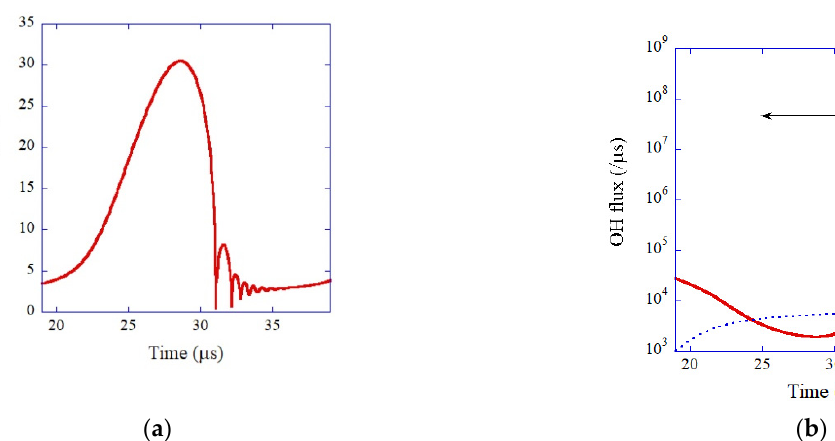
Figure 7. The calculated results under the condition of single bubble sonochemistry [24]. A SBSL bubble with R 0 = 3.6 μ m in a steady state in water at 3 °C is irradiated by an ultrasonic wave of 52 kHz and 1.52 bar. ( a ) The bubble radius ( b ) The dissolution rate of OH radicals into the liquid from the interior of the bubble (solid line) and its time integral (dotted line). Copyright 2005. with the permission of AIP Publishing.